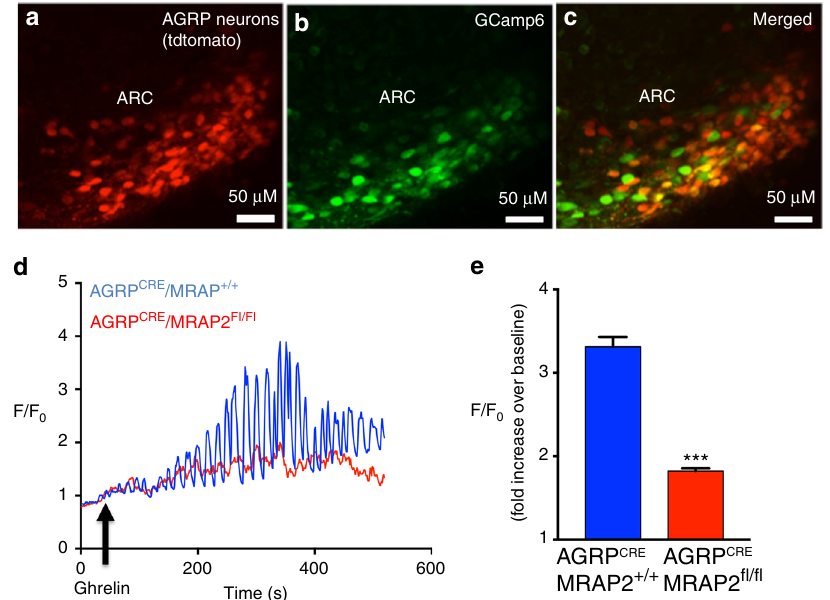
Fig. 6 MRAP2 potentiates the ghrelin-stimulated calcium response in AGRP neurons. ( a – c ) Two-photon images of the ARC of a AGRP CRE mouse injected with viruses coding for Cre-dependent tdTomato and GCamp6. d Representative traces of GCamp6 fl uorescence intensity over time in AGRP neurons from AGRP CRE /MRAP2 +/+ ( blue ) and AGRP CRE /MRAP2 FL/FL ( red ) mice. e Quanti fi cation of ghrelin-stimulated calcium responses in AGRP neurons from AGRP CRE /MRAP2 +/+ mice ( n = 5 mice/268 neurons) and AGRP CRE /MRAP2 Fl/Fl mice ( n = 7 mice/415 neurons). Error bars are SEM. *** p <